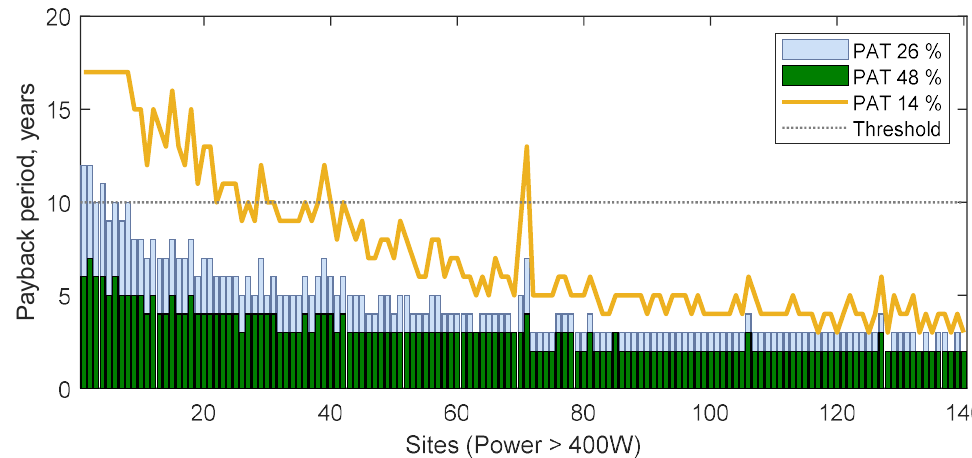
Figure 13. Payback period in the evaluated sites.